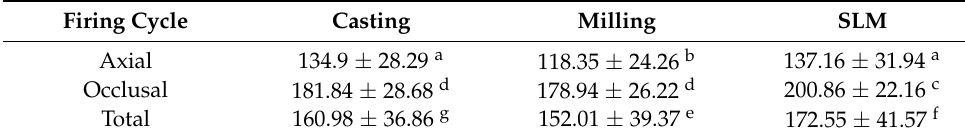
Table 2. Internal gap of casting, milling, SLM single dental crown. Firing Cycle Casting Milling SLM Axial 134.9 ± 28.29 a